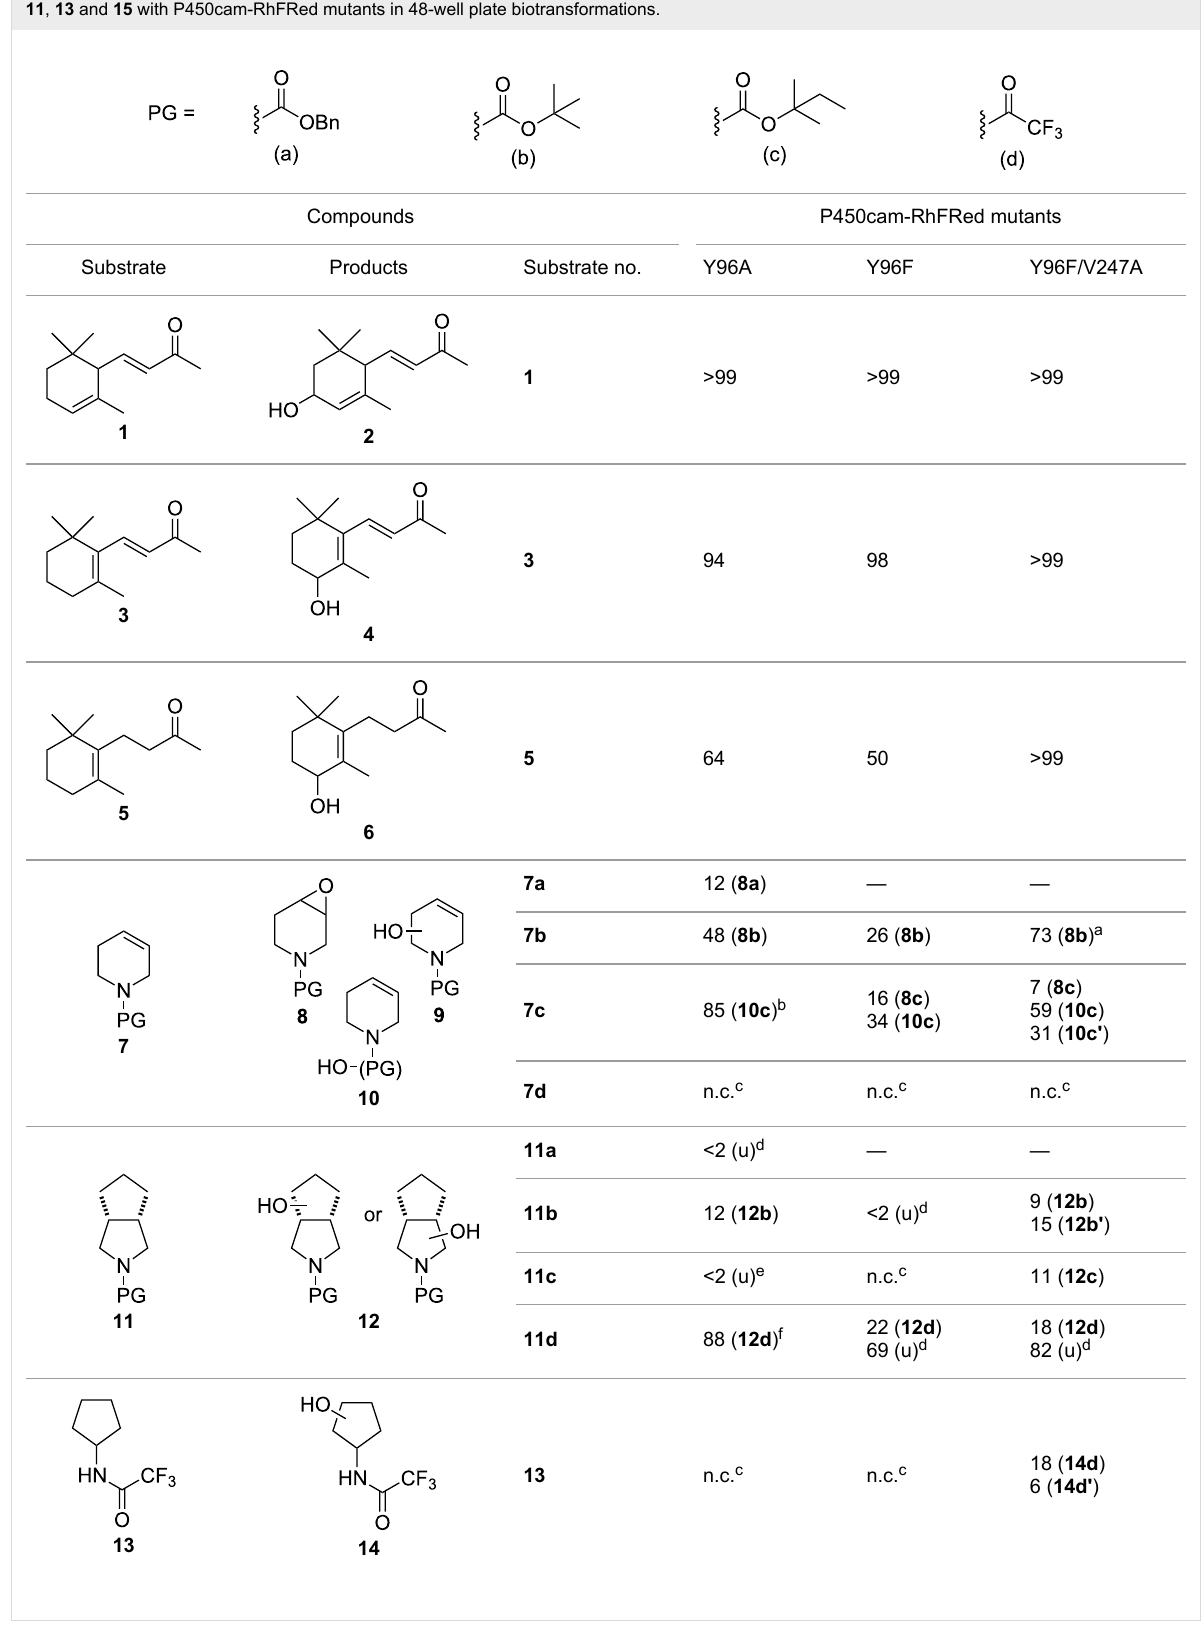
Table 1: Conversion (% relative peak-area by GC–MS of extracted reaction mixtures), after 24 h, of substrates 1 , 3 , 5 , and, after 48 h, of substrates 7 , 11 , 13 and 15 with P450cam-RhFRed mutants in 48-well plate biotransformations.